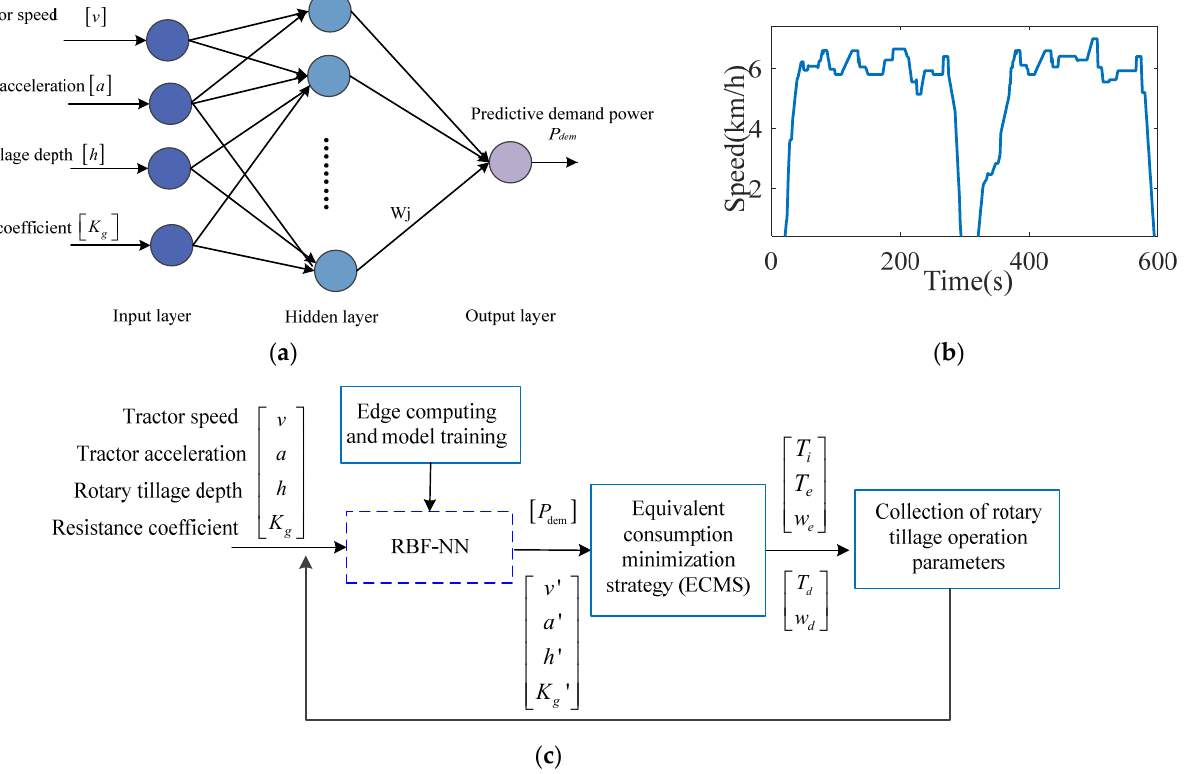
Figure 5. The scheme of equivalent consumption minimization strategy. ( a ) The structure of RBF neural network. ( b ) The speed curve of tractor rotary tillage. ( c ) ECMS based on predictive power demand.